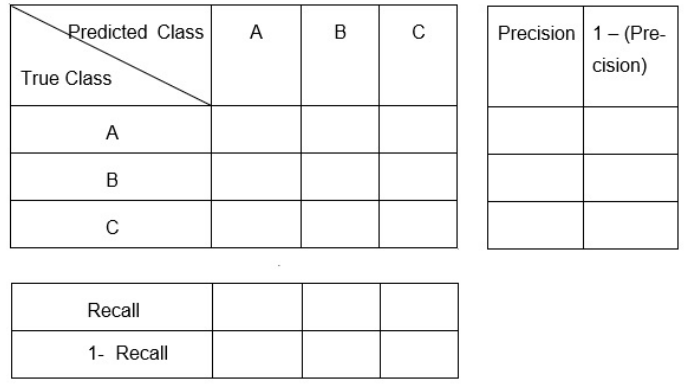
Figure 5. Confusion Matrix for